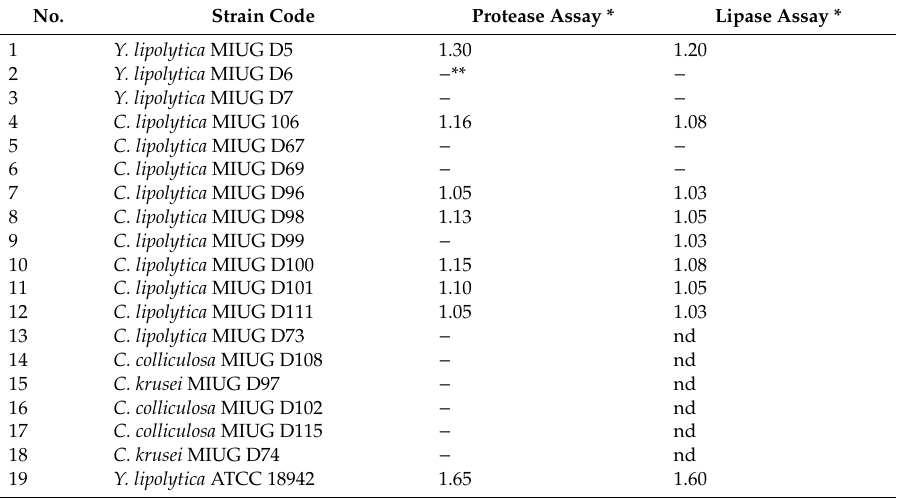
Table 1. Selection of the yeast strains able to produce lipases and proteases.